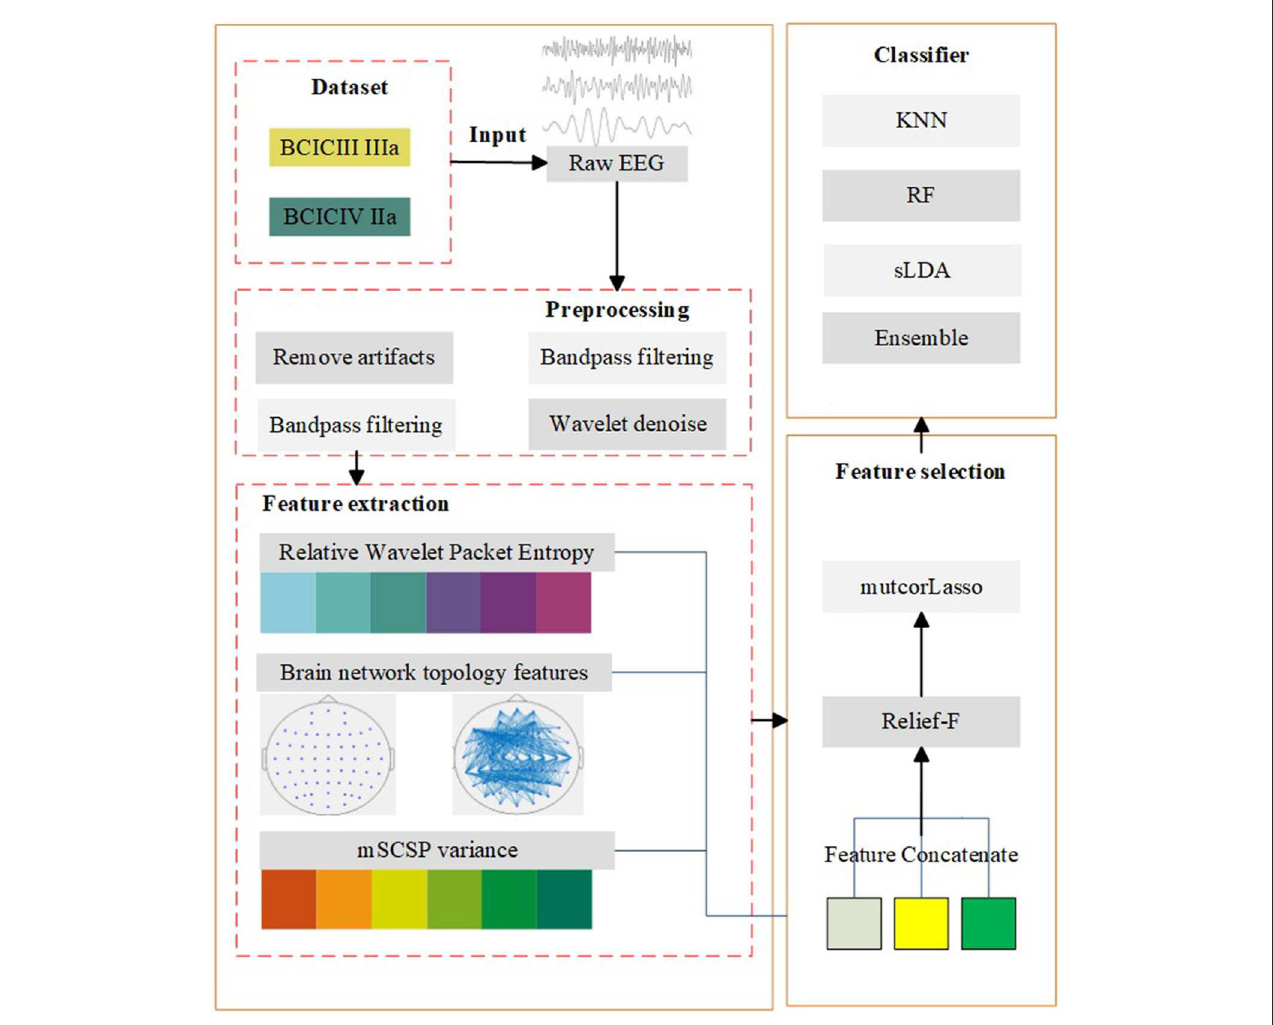
FIGURE1 Algorithm model. The diagram consists of five main parts: data introduction, preprocessing, feature extraction, feature selection, and